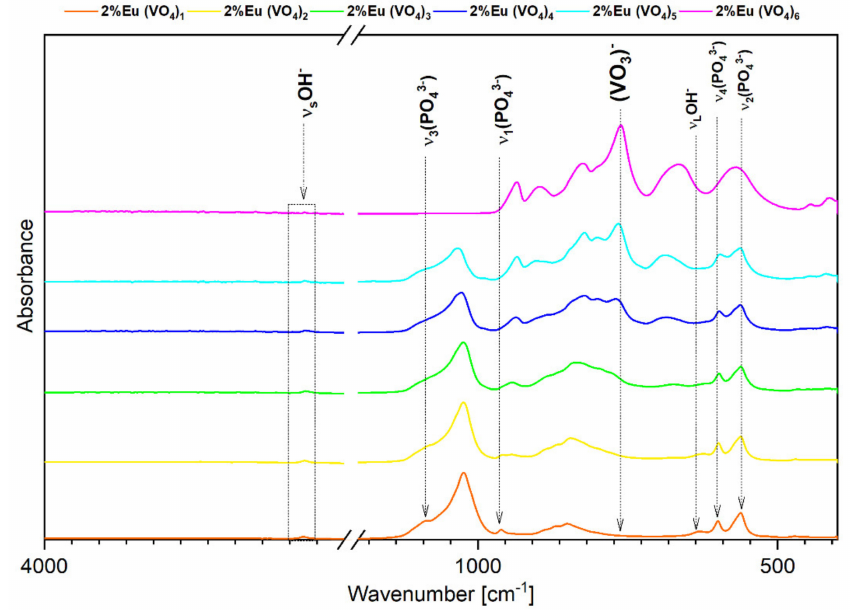
Figure 2. FTIR spectra of Ca 9.8 Eu 0.2 (PO 4 ) 6 − x (VO 4 ) x (OH) 2 , where x = 1, 2, 3, 4, 5, and